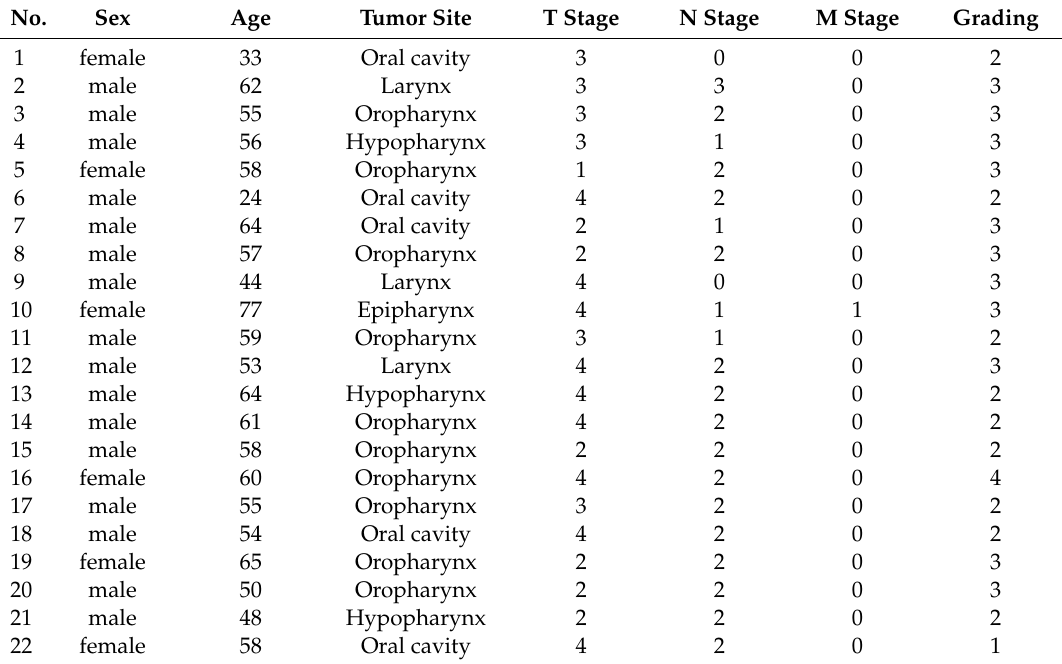
Table 1. Clinical characteristics of the patients enrolled in the study.